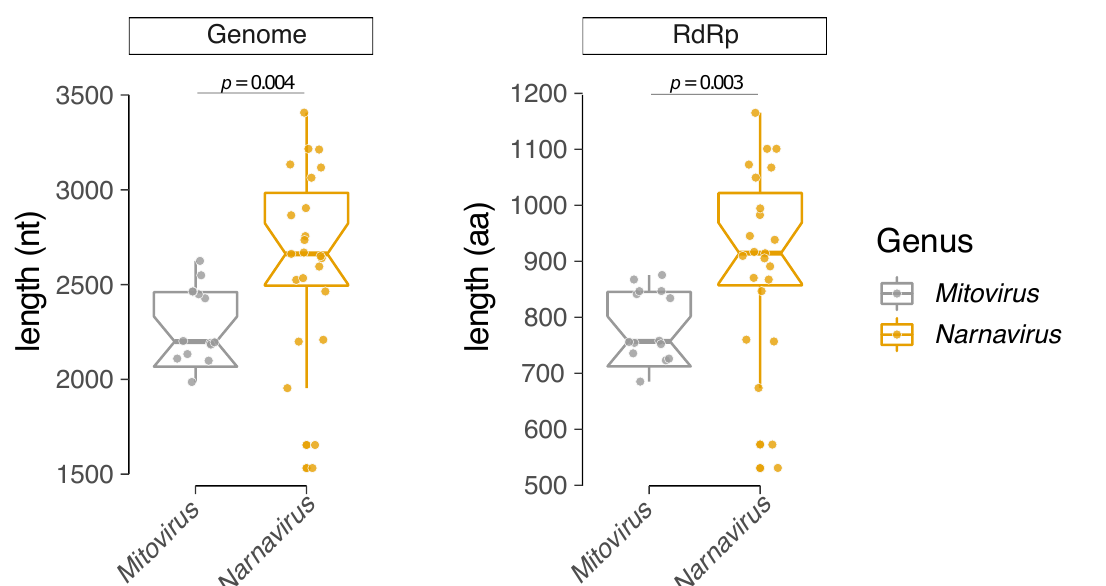
Figure 3. Comparative genome length. Comparison of genome and RNA-dependent RNA polymerase (RdRp) lengths of viruses of the genera Narnavirus and Mitovirus .